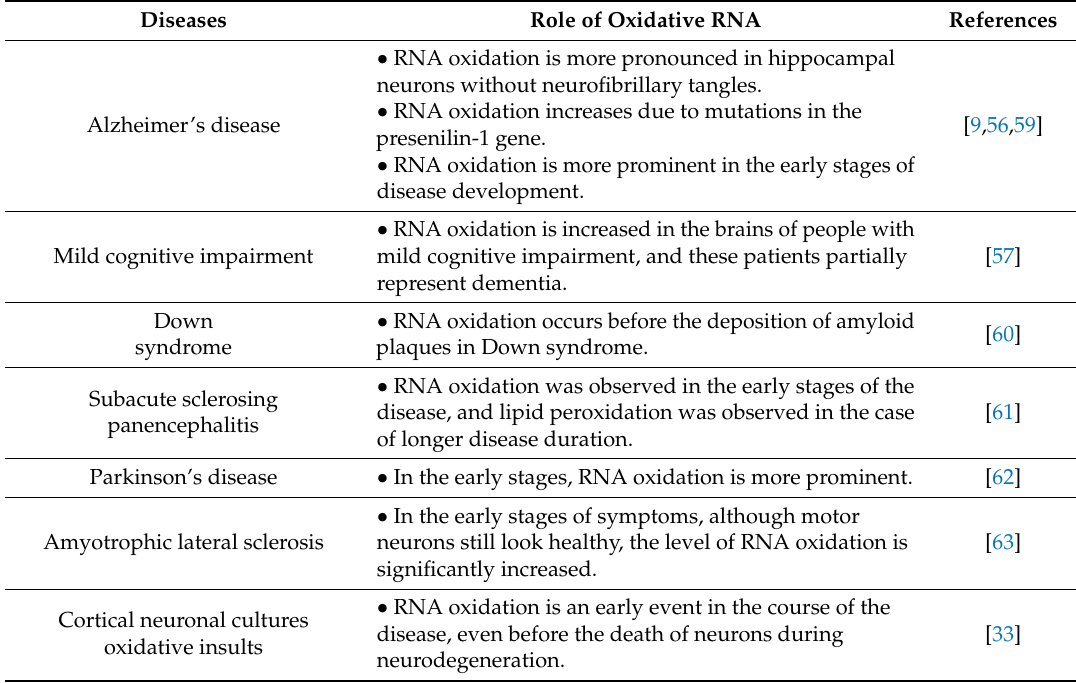
Table 2. Review demonstrating that RNA oxidation plays a remarkable role in